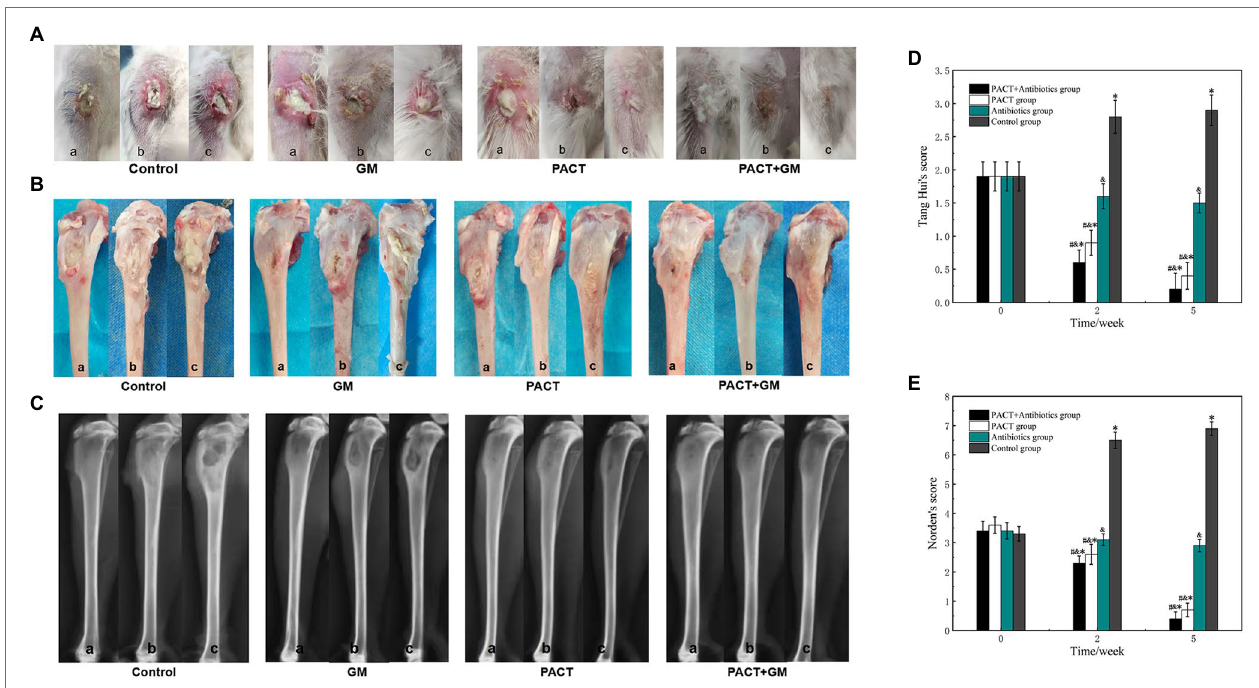
FIGURE 3 | The results of visual observation and X-ray examination, A, B, and C samples represent before treatment, 2 weeks after treatment, and 3 weeks after treatment, respectively. (A) Macroscopic observation of the soft tissues in the four groups at different time periods; (B) macroscopic observation of the bone tissues in the four groups at different time periods; (C) X-ray images for the four groups at different time periods; (D) Scoring results from naked eye observations for each group; and (E) X-ray scores for each group. * p < 0.05 indicates a statistically significant difference compared with before treatment, # p < 0.05 indicates a statistically significant difference compared with the control group, and & p < 0.05 indicates a statistically significant difference compared with the antibiotic group.